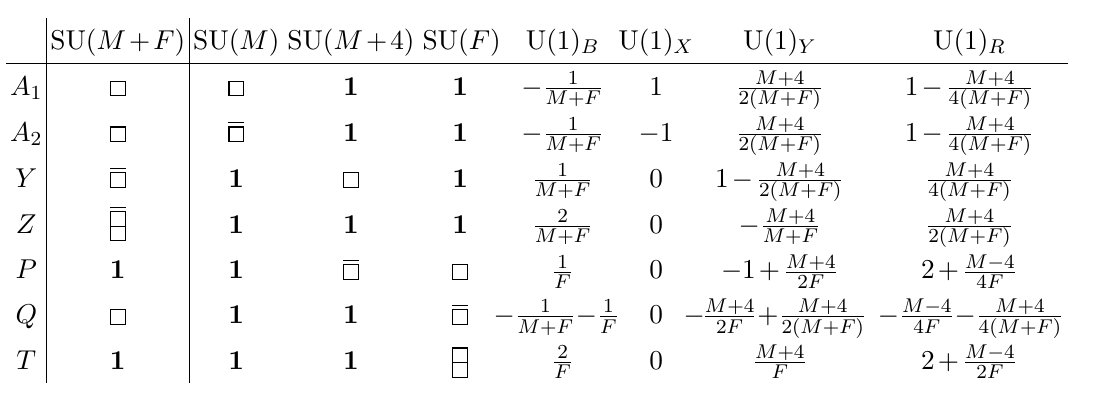
. The a -maximized R -charge is U(1) sc USp